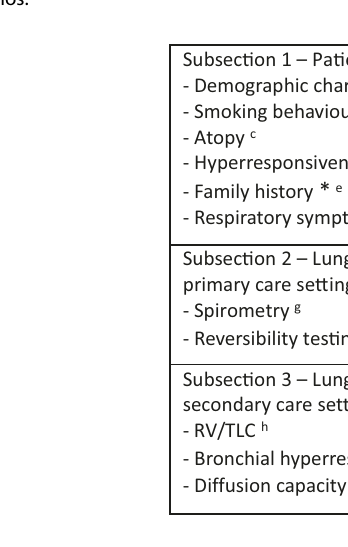
Table 2. Categorization of variables in three subsections based on diagnostic availability and multivariable logistic regression analysis for the three